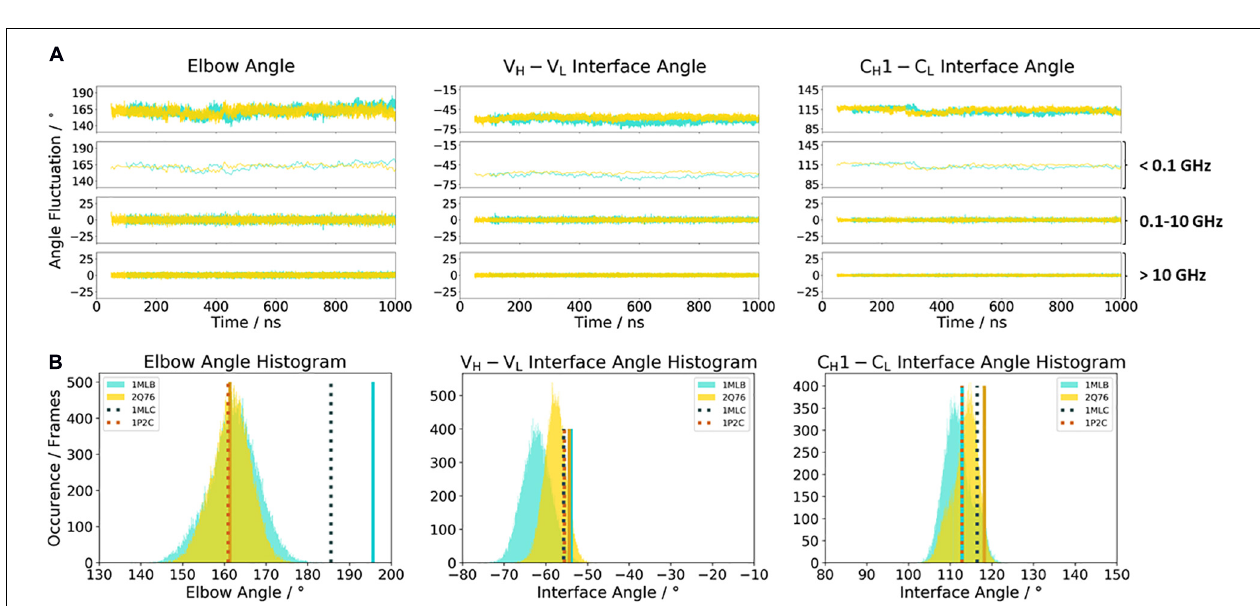
FIGURE 5 | (A) Influence of affinity maturation on the relative interface and elbow angle distributions. The D44.1 Fab (colored in cyan) reveals a broader interface and elbow angle distribution compared to the matured F10.6.6 antibody. The calculations of the FFT of the respective distributions are displayed, showing the angle variations occurring faster than 1 ns, between 0.1 and 10 ns, and slower than 10 ns. (B) Histograms of the respective interface and elbow angle distributions, including the respective X-ray structures of the affinity maturation pair D44.1 and F10.6.6, which were used as starting structures for molecular dynamics simulations.